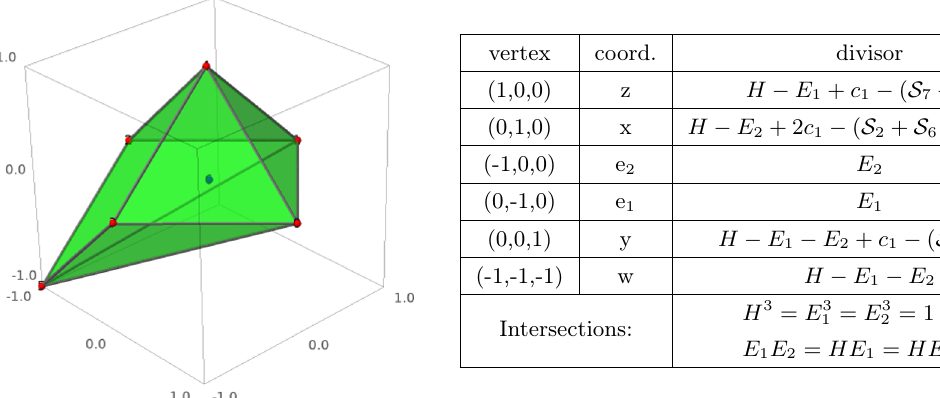
Figure 5 . The polytope and data associated to the ambient space Bl 2 P 3 of nef (21,0). The latter generically leads to a rank two Mordell-Weil